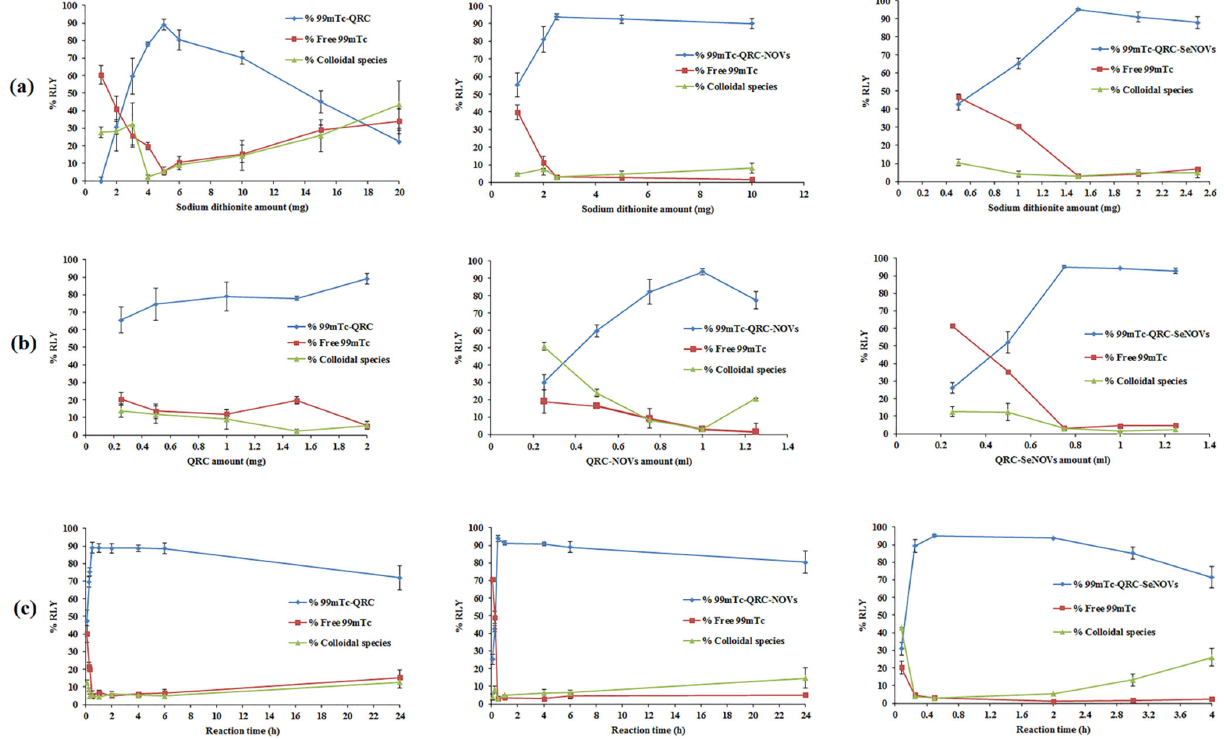
Figure 6. Effect of different conditions on the RLY of the 99m Tc ‐ QRC complex: ( a ) sodium dithionite amount, ( b ) QRC amount, and ( c ) reaction time.